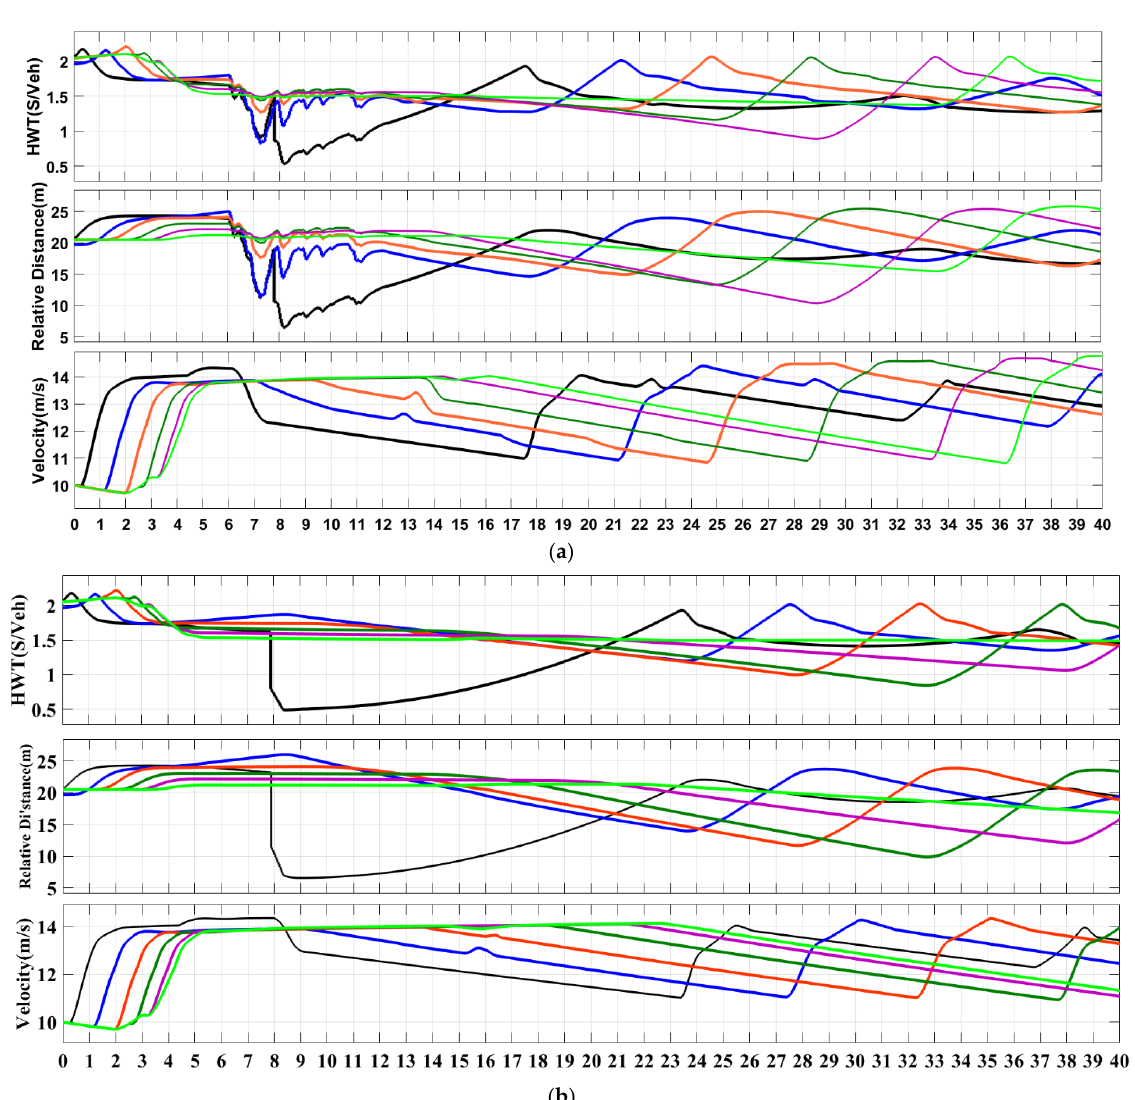
Figure 13. Acceleration thermal diagram of CAVF fleet and CACCNF fleet under scenario 2: ( a ) CAVF fleet acceleration heatmap; ( b ) CACCNF fleet acceleration heatmap.